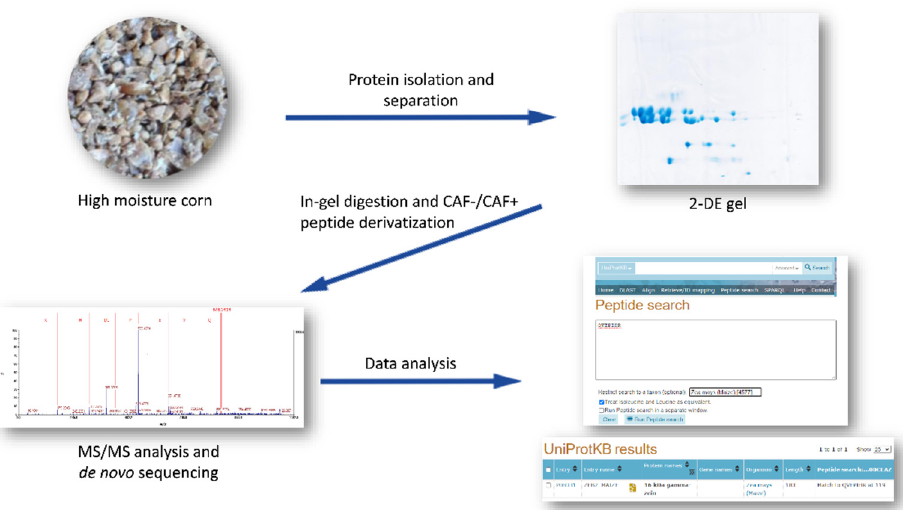
Figure 1. Schematic representation of chemically activated fragmentation (CAF − /CAF+) mass spectrometry (MS) technique for protein identification. From top left to bottom right: zein proteins isolated from the fresh and the high-moisture corn samples were separated on 2-DE gels, visual- ized with Coomassie brilliant blue, and analyzed with PDQuest 2-D image analysis software. All visible spots were excised from the gels, processed by in-gel digestion and CAF − /CAF+ peptide derivatization and analyzed using the MS technique for protein